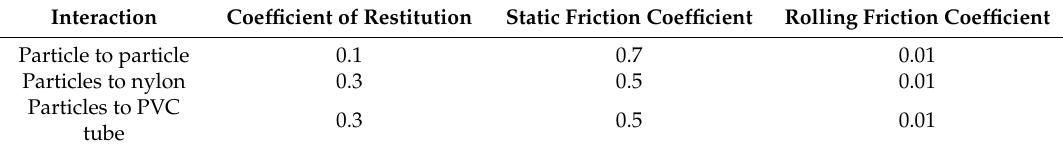
Table 2. Starch granules’ contact properties.